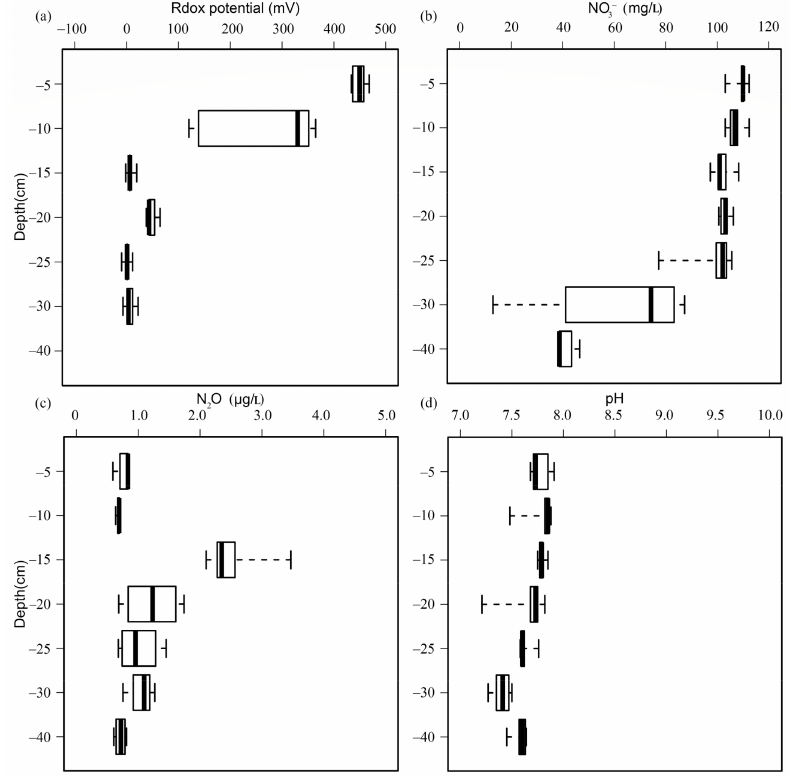
Figure 6. Redox potential ( a ), nitrate NO 3 − ( b ), and dissolved gasses N 2 O ( c ) as well as the pH ( d ) at different depths in the mesocosm